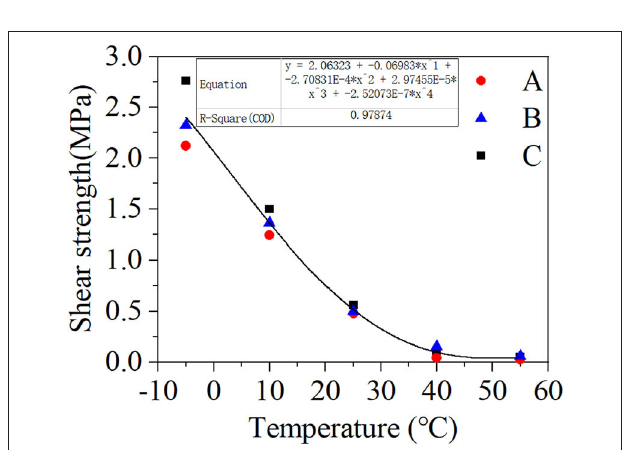
FIGURE 5 | The functional relationship between temperature and bonding degree.